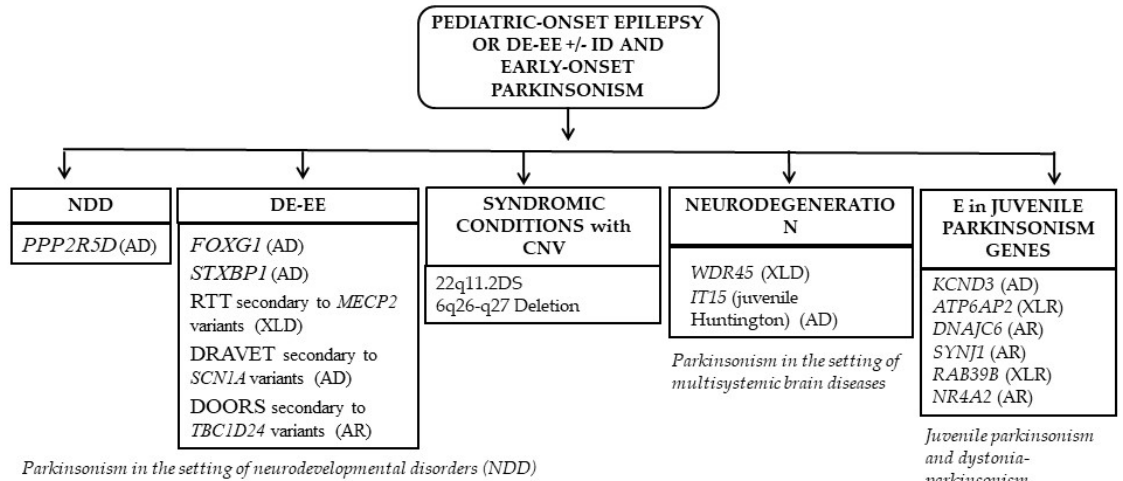
Figure 3. Classification and overview of the disorders described in this review. List of abbreviations: AD: autosomal dominant, AR: autosomal recessive, ATP6AP2 : ATPase H+ transporting accessory protein 2, CNVs: copy number variations, DE ‐ EE: developmental and epileptic encephalopathies, DNAJC6 : DnaJ heat shock protein family (Hsp40) member C6, DS: deletion syndrome, E: epilepsies, FOXG1 : forkhead box G1, ID: intellectual disability, IT15: huntingtin, KCND3 : Potassium Voltage ‐ Gated Channel Subfamily D Member 3, MECP2 : methyl ‐ CpG binding protein 2, NDD